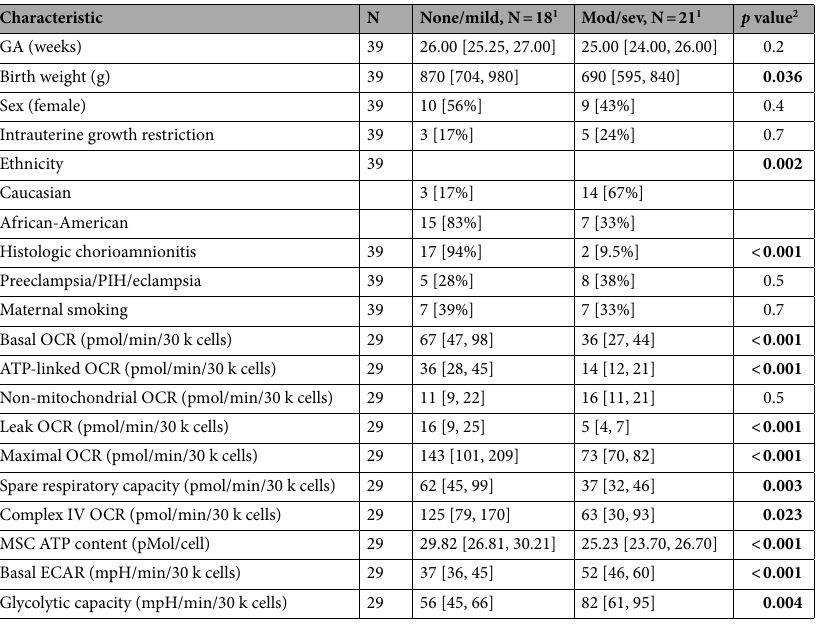
Table 1. Clinical characteristics and MSC bioenergetics by BPD Status. 1 Median [IQR]; n [%] 2 Student’s t-test; Pearson’s Chi-squared test; Wilcoxon rank sum exact test. Significant values are in